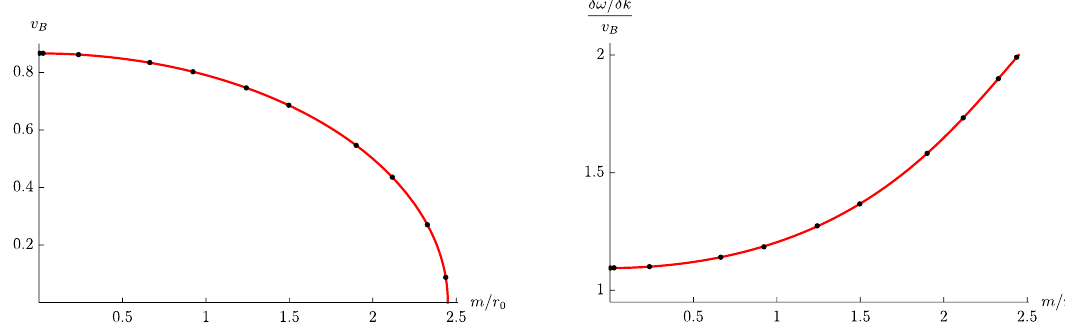
Figure 2 . These plots show the dispersion relation ! ( k ) of the hydrodynamic pole in (3.7) as a function of imaginary k for the choices m=T = 1 = 100 and m=T = 100. The blue lines are the hydro- dynamic approximations (3.36) (left panel) and (3.37) (right panel) to the small k hydrodynamic behaviour. The black dots correspond to the exact dispersion relation extracted from our numerics. Despite the qualitatively di(cid:11)erent small k behaviour, in all cases we (cid:12)nd this dispersion relation passes through the special point (1.3) such that ! ( ik 0 ) = i(cid:21) for k 0 = (cid:21)=v B .